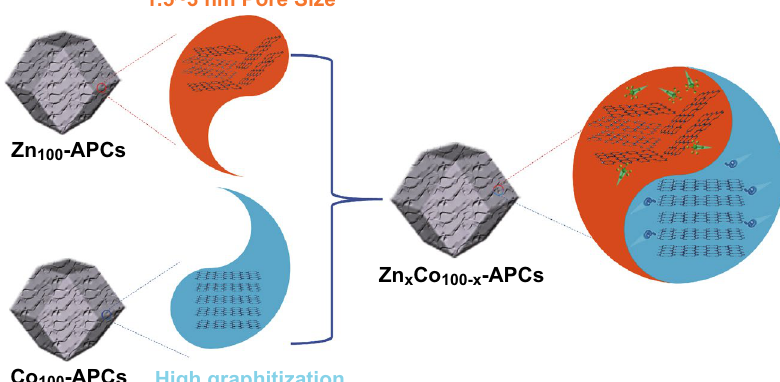
Fig. 7 Schematic illustration of the synthesis of the desired carbon cathode through the ingenious incorporation of high graphitization and appropriate pore size